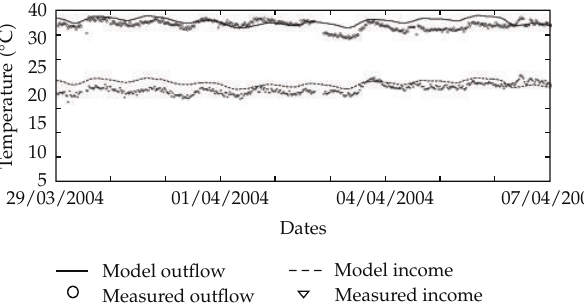
Figure 13: Comparison of the measured and modeled temperaturesin the income and outflow of the power plant with the 6th units in operation for the days between 29 March and 7 April